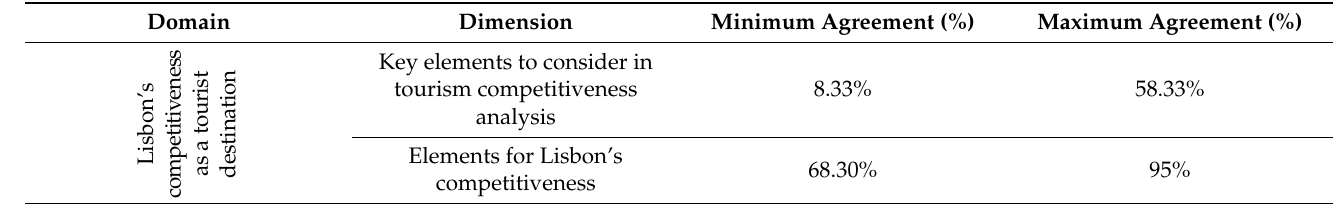
Table 8. Maximum and minimum agreement of the second domain of the interviews. Source: Elaborated by the